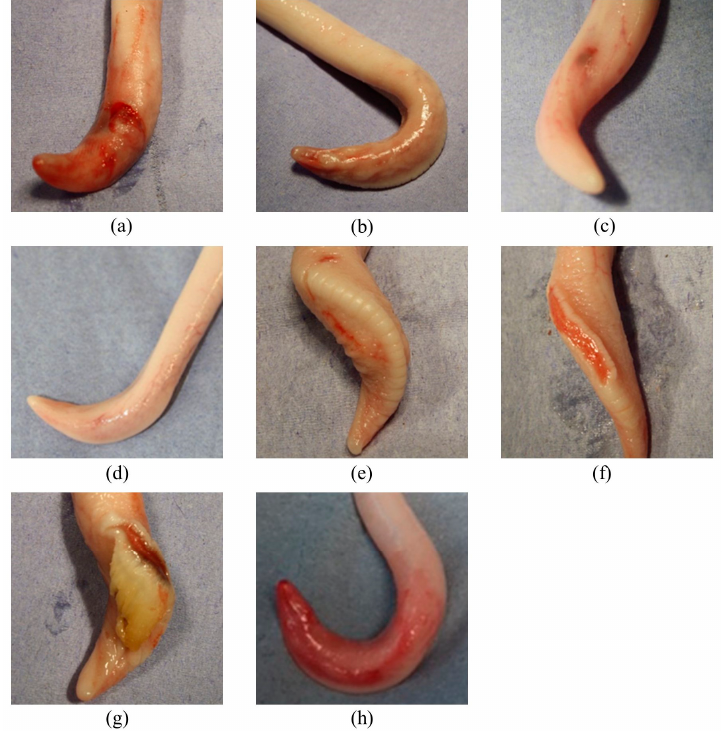
Figure 1. Pars libra penis with ( a ) wounds; ( b ) multiple scars; ( c ) hematoma; ( d ) no injuries; ( e ) slightly hypertrophic ridge; ( f ) slightly hypertrophic ridge with abrasions; ( g ) ridge with hyperkeratosis; ( h ) abrasion of the glans penis.